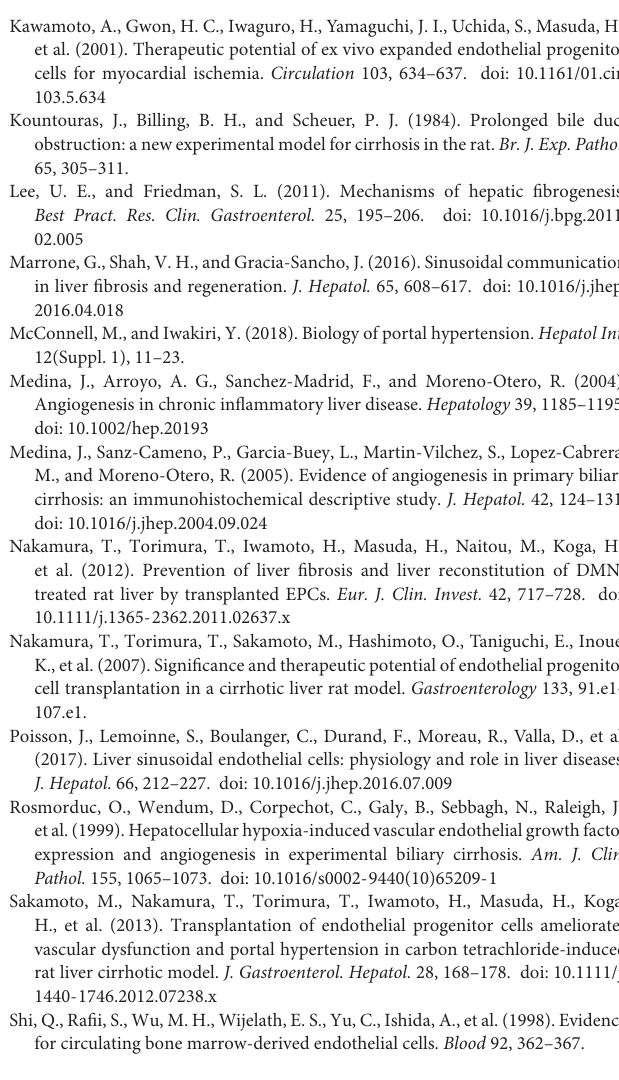
FIGURE S3 | (A) Representative images (10 × ) of LX2 cells (HSCs) incubated with conditioned media (CM) from healthy (control) and cirrhotic patient EPCs. (B) Bar diagram showing absorbance of MTT assay depicting cell proliferation in different conditions. (C) Absorbance showing FGF levels in cells alone and co-cultured cells. TABLE S1 | Characteristics of patients used in the study. TABLE S2 | List of Antibodies used in the